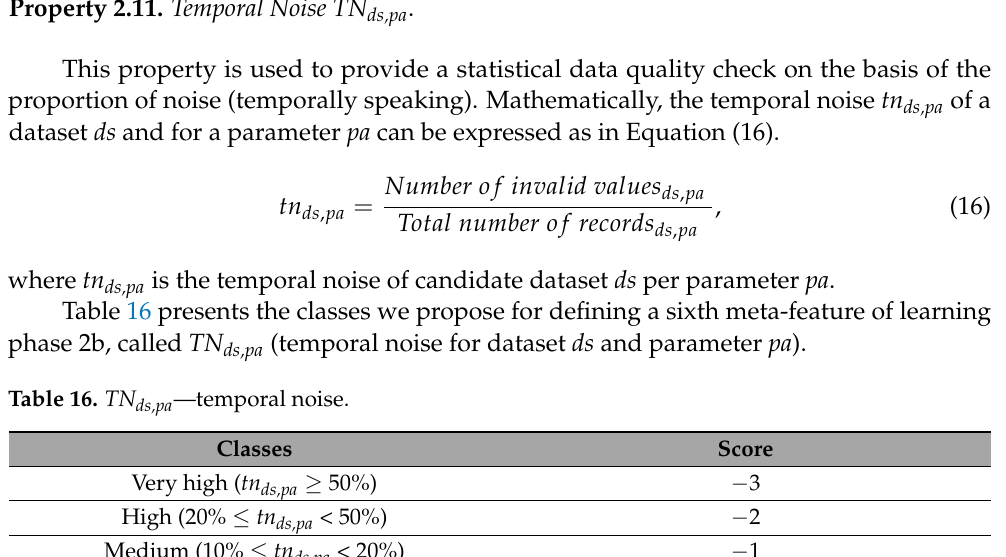
Table 15. TDi ds,pa —temporal distribution. Classes Score Heterogeneous distribution (0 < tdi ds,pa < 30%) − 1 Homogeneous distribution ( tdi ds,pa ≥ 30% or tdi ds,pa = 0) 0